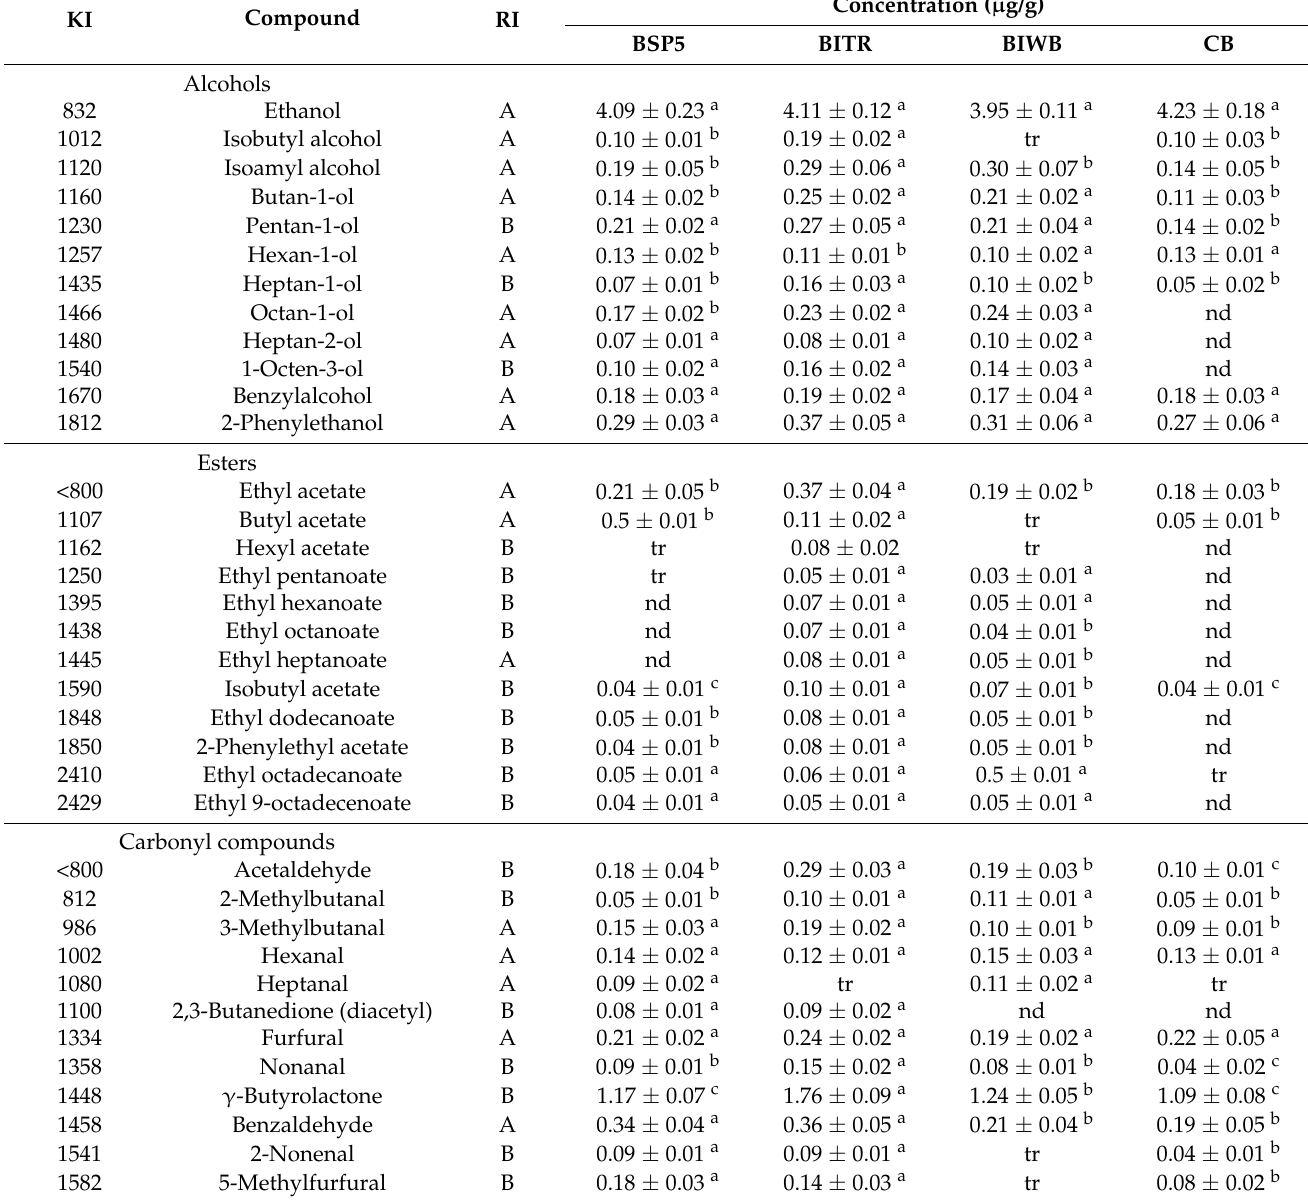
Table 2. SPME GC/MS analysis of aroma-related compounds ( µ g/g) of breads made with sourdoughs containing freeze-dried free and immobilized L. paracasei SP5 and with the control